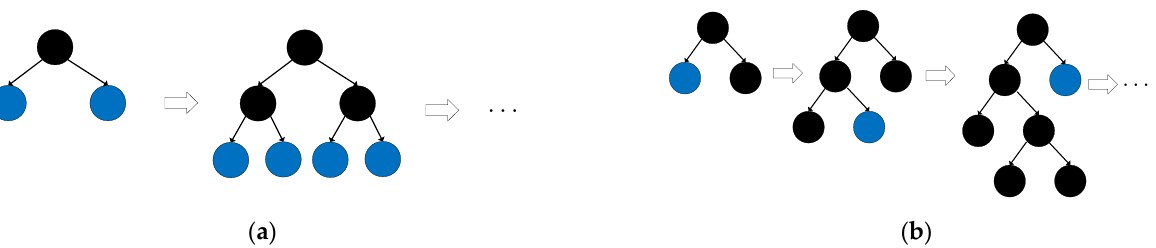
Figure 1. Histogram-based algorithm.